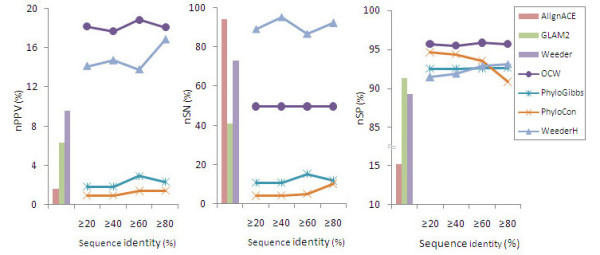
Performance comparisons of different tools on simulated data. The predictions shown in histogram are from AlignACE, GLAM2 and Weeder. These three tools are based on over-represented word detection. The predictions shown in line chart are from OCW, PhyloGibbs, PhyloCon, and WeederH, which introduced phylogenetic information in the algorithms. The extent of convergence of artificial orthologous sequences used in these tools is represented by the sequence identity.